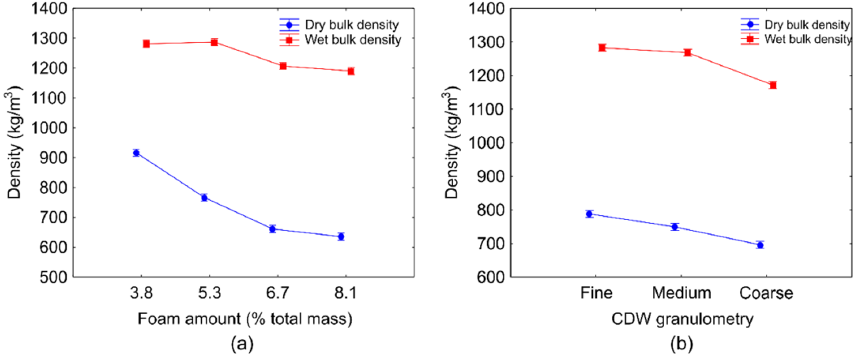
Figure 5. Densities (DBD and WBD) as a function of FA ( a ) and CDW granulometry (CDWG) ( b ).